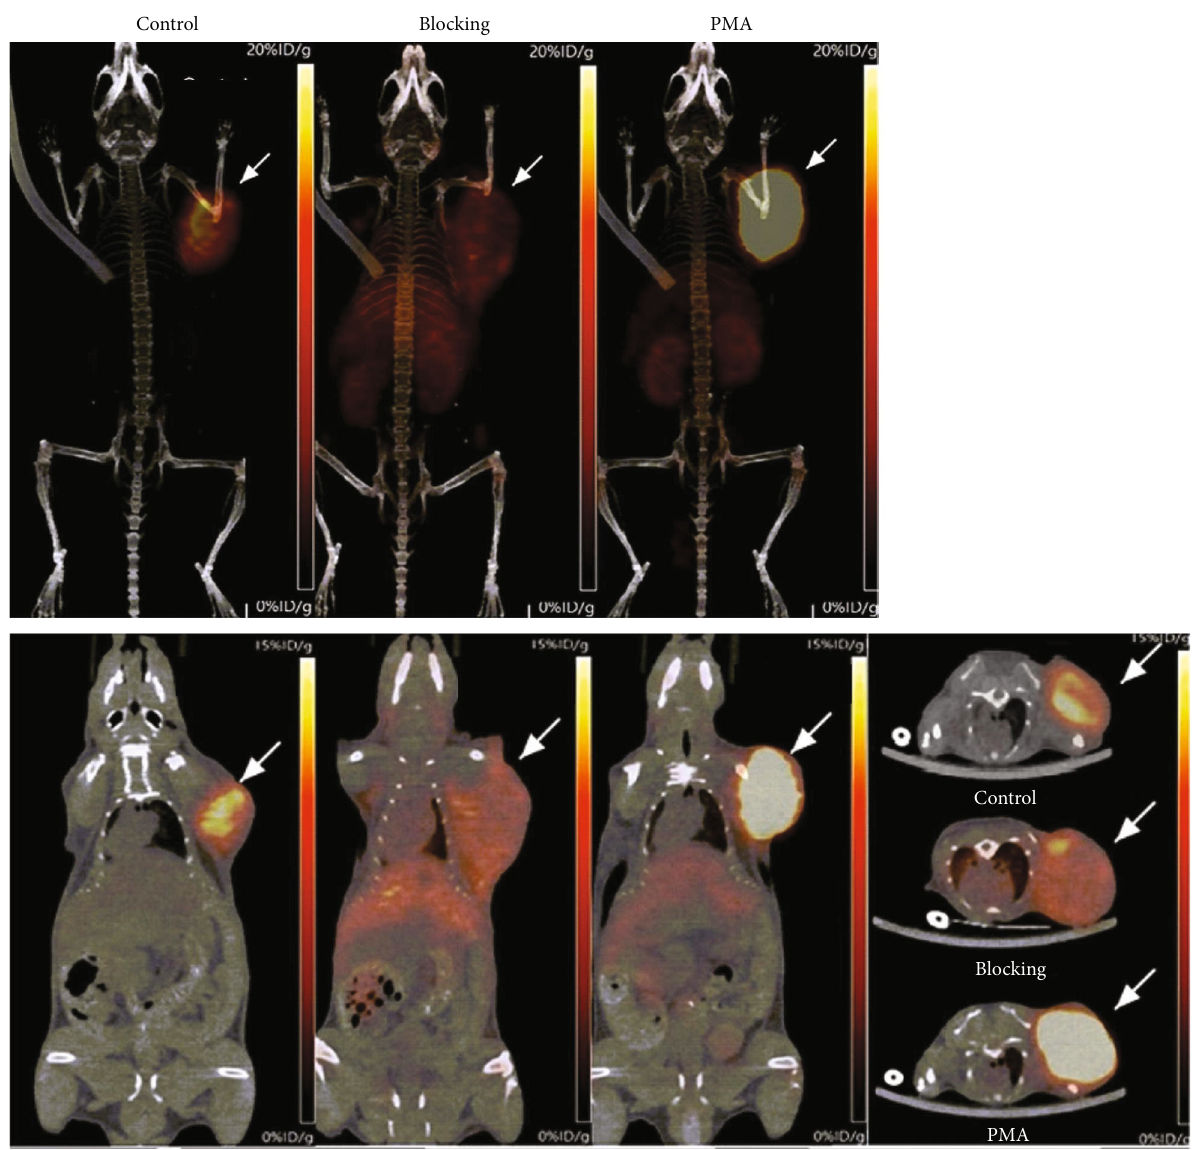
Figure 5: PET/CT imaging of tumor 89 Zr-PD-1 IgG uptake and e ff ects of PMA stimulation. Representative maximum intensity projection images (a – c) and coronal (d – f) and transaxial PET images (g) of mice at baseline, with excess antibody blocking, and after PMA treatment at 6 days after intravenous 89 Zr-PD-1 IgG. Arrows indicate EL4